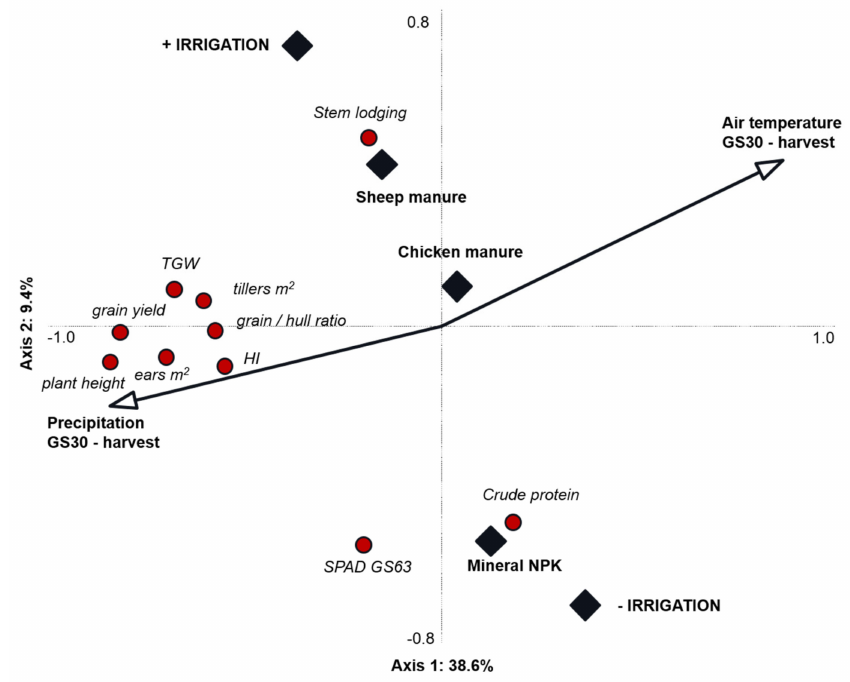
Figure 2. Biplot derived from the redundancy analysis showing the relationship between environ- mental (air temperature, precipitation) and agronomic (fertilizer type and supplementary irrigation) explanatory variables/drivers and grain yield, stem lodging, crude protein content and yield-related growth parameters (harvest index [HI], plant height, tillers per m 2 , ears per m 2 , thousand grain weight [TGW], grain/hull ratio and chlorophyll content [SPAD] at GS63) in spelt wheat variety Rubiota. Fixed explanatory variables are shown as black diamonds ( (cid:7) ) and were: (a) irrigation (without irrigation F = 13.7, p = 0.002; with irrigation F = 13.7, p = 0.002) and (b) fertilizer type (mineral NPK F = 5.4, p = 0.002; sheep manure F = 1.4, p = 0.242). Continuous explanatory variables are shown as arrows and were (c) air temperature between GS30 and harvest (F = 34.2, p = 0.002) and (d) precipitation (F = 6.0, p =